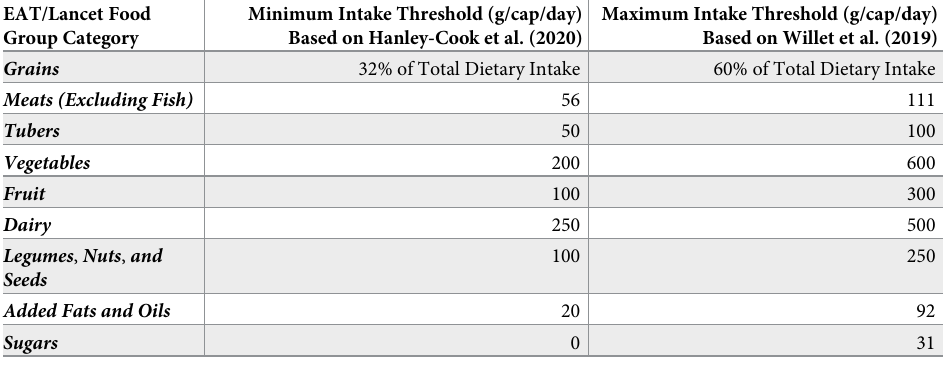
Table 1. Minimum and maximum recommended dietary intake of 9 food categories—Based on EAT-Lancet Die- tary Guidelines and [42]. EAT/Lancet Food Group